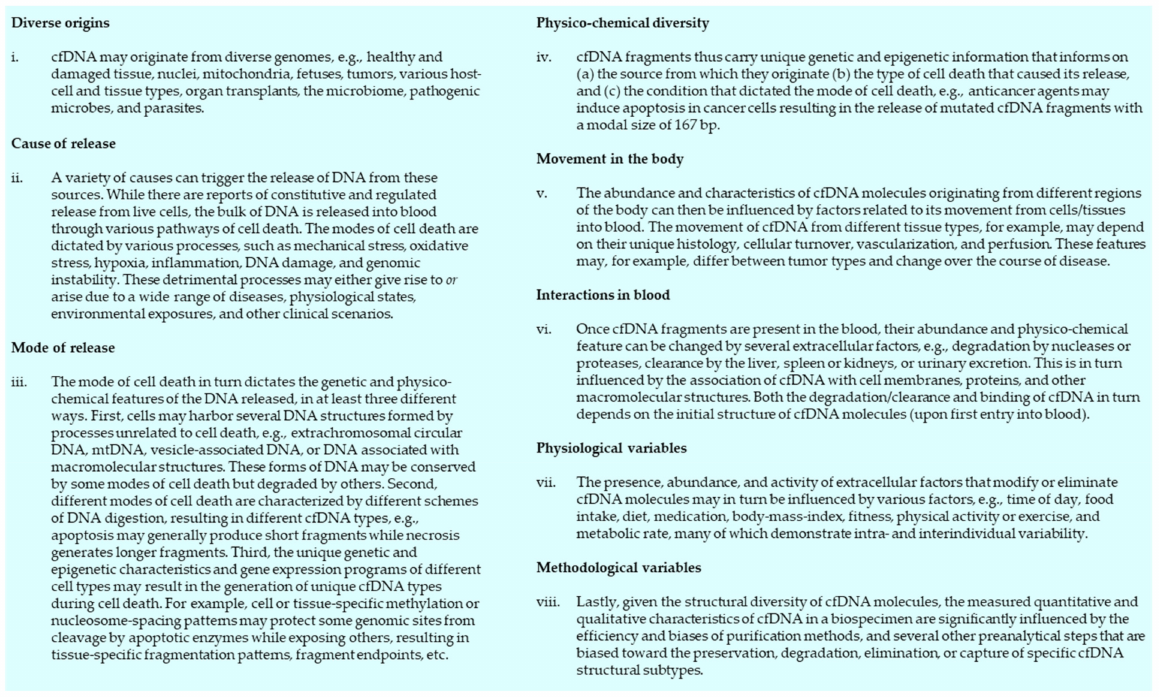
Figure 8. Factors that contribute to the complexity and fluctuation of cfDNA